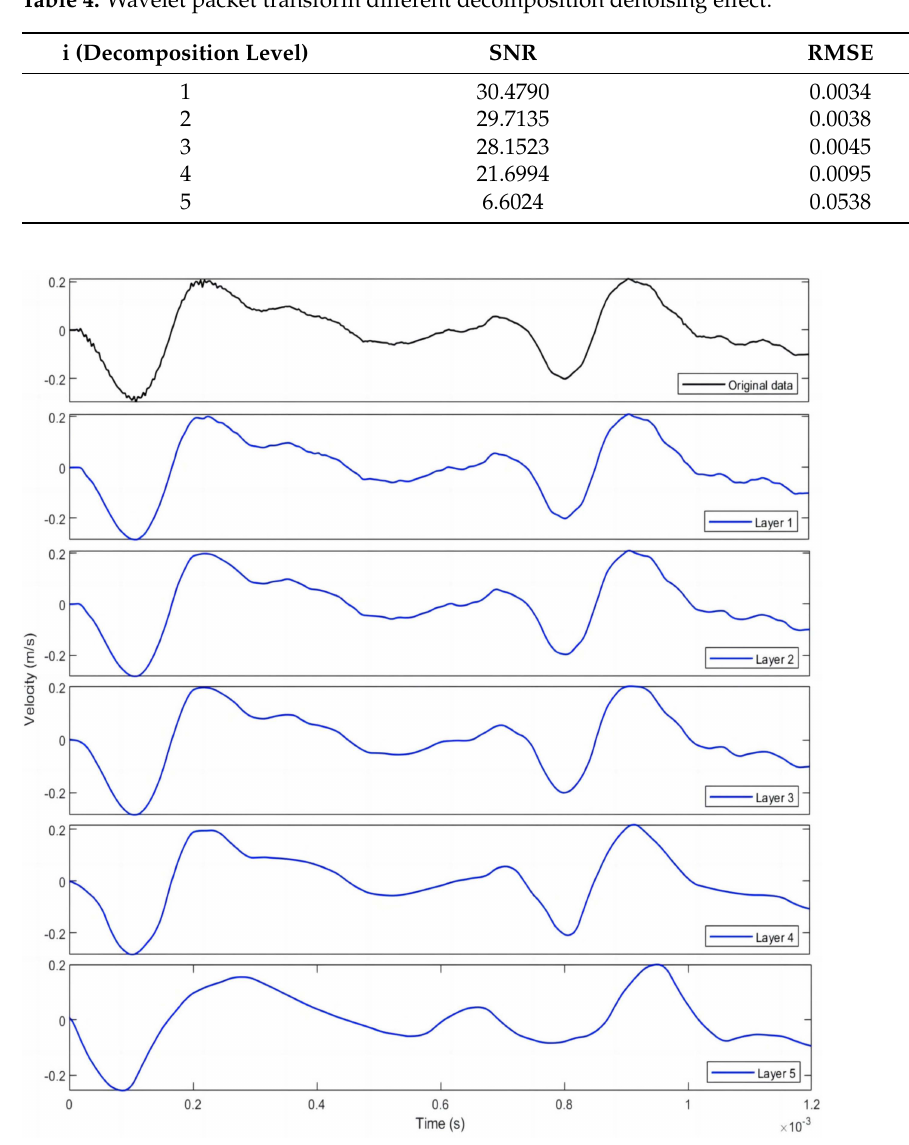
Figure 8. Denoising effect of different